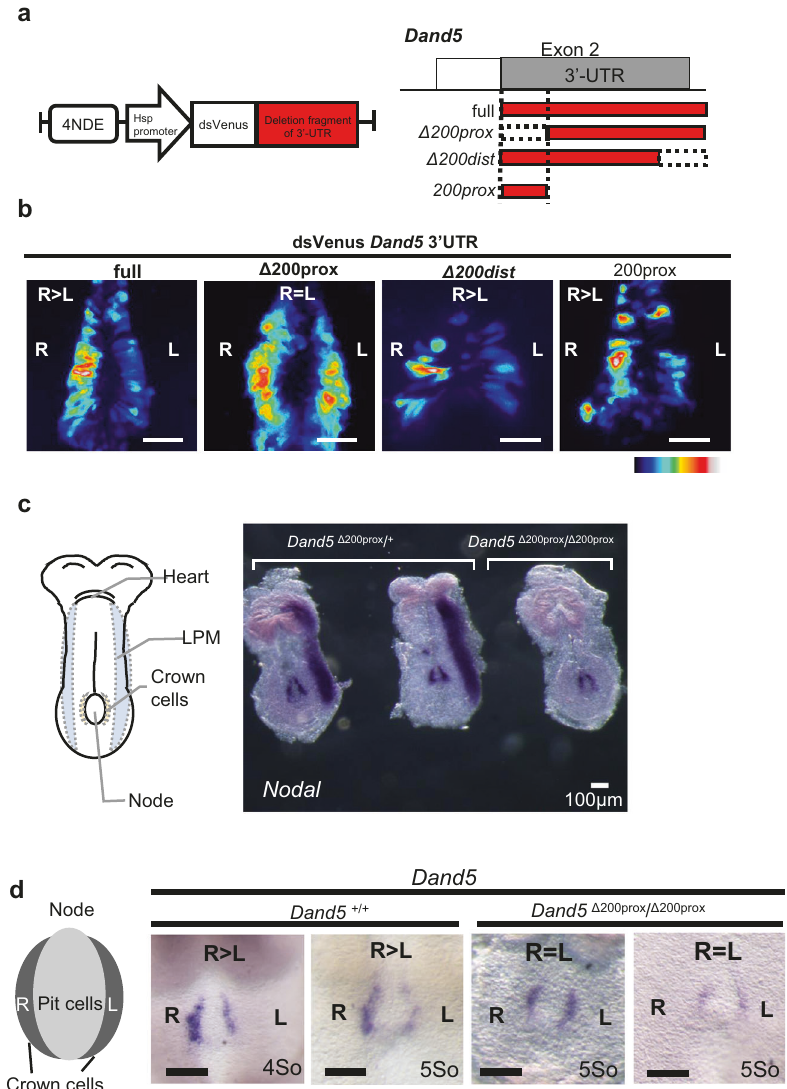
Fig. 3 A 200-nucleotide conserved proximal region of the 3 ′ -UTR is required for L-R asymmetric accumulation of Dand5 mRNA. a Schematic representation of the NDE-Hsp-dsVenus transgene fused to the Dand5 3 ′ -UTR (left) or to a series of various 3 ′ -UTR fragments ( right ). b Fluorescence of dsVenus at the node of four- to six-somite stage mouse embryos harboring the indicated transgene (see also Supplementary Fig. 1b). Images are representatives of at least three embryos for each transgene. Scale bar, 50 µ m. c WISH analysis of Nodal expression in Dand5 Δ 200prox/ + and Dand5 Δ 200prox/ Δ 200prox embryos at embryonic day (E) 8.0. Left-sided expression of Nodal in LPM was lost in the Dand5 Δ 200prox/ Δ 200prox embryo. Scale bar, 100 µ m. Images are representatives of at least four embryos for each genotype. d WISH analysis of Dand5 expression at the node of Dand5 + / + and Dand5 Δ 200prox/ Δ 200prox embryos at four- to fi ve-somite stages (E8.0). Two representative embryos are shown for each genotype. L-R asymmetry of Dand5 mRNA at the node was lost in the Dand5 Δ 200prox/ Δ 200prox embryo. Scale bars, 100 µ (RNP) complexes (Supplementary Fig. 7c), with the highest af fi nity complex RNP 1 showing an apparent Kd of 233 nM for the 225-nucleotide probe, compared to only 120 nM for the shorter 35-157 and 66-110 probes, respectively. Additional RNPs